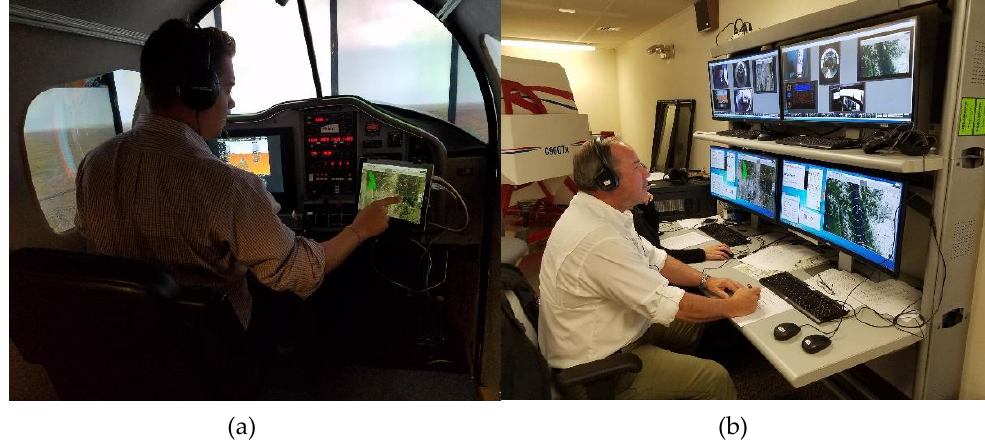
Figure 1. ( a ) The Flight Training Device (FTD) cockpit, configured as a Mooney aircraft; ( b ) air traffic control (ATC) station, with an experimenter playing the role of ATC.